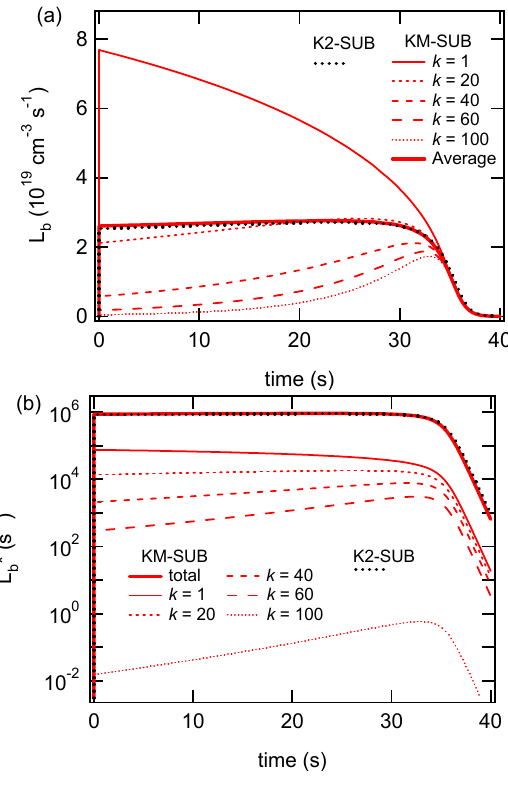
Fig. 3. Temporal evolution of bulk concentration profiles for model base case 1 for (a) ozone and (b) oleic acid (KM-SUB with n = 100). The y-axis indicates the radial distance from the particle cen- ter ( r) normalized by the particle radius, ranging from the particle core ( r / r p = δ/r p ≈ 0) to the near-surface bulk ( r/r p = 1). The col- ored lines are isopleths of bulk concentration with labeled in units of cm − 3 (blue=low, red=high). The black solid line represents the reacto-diffusive length for ozone normalized by the particle radius (1 − l rd , X /r p ) . The black dotted line represents the 50% isoline for the concentration difference between the particle core and the near- surface bulk, and the black dashed line shows 63% isoline of L ∗